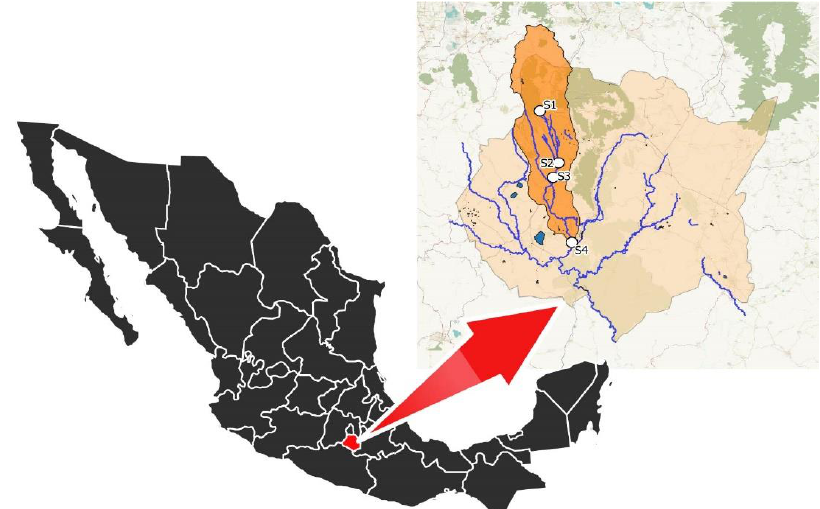
Figure 1. Map of M é xico and the hydrology of Morelos. The Apatlaco basin is in Figure 1. Map of México and the hydrology of Morelos. The Apatlaco basin is in orange.